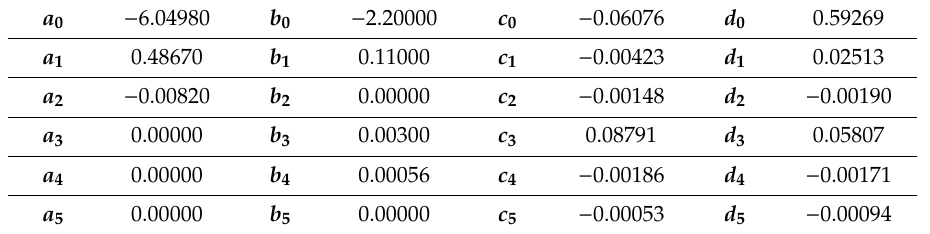
Table 7. Calculated coe ffi cients for the “Equation Fit Approach”, air-to-air heat